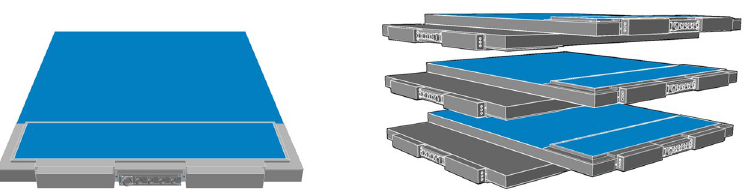
Figure 5. Left: Sketch of the aluminium shell of a detection plane, consisting in 64 scintillator bars and the Front-End Electronics. Right: Sketch of the muon telescope, consisting of a vertical sequence of three modules, mounted horizontally on a support (not shown) and evenly spaced in the vertical direction